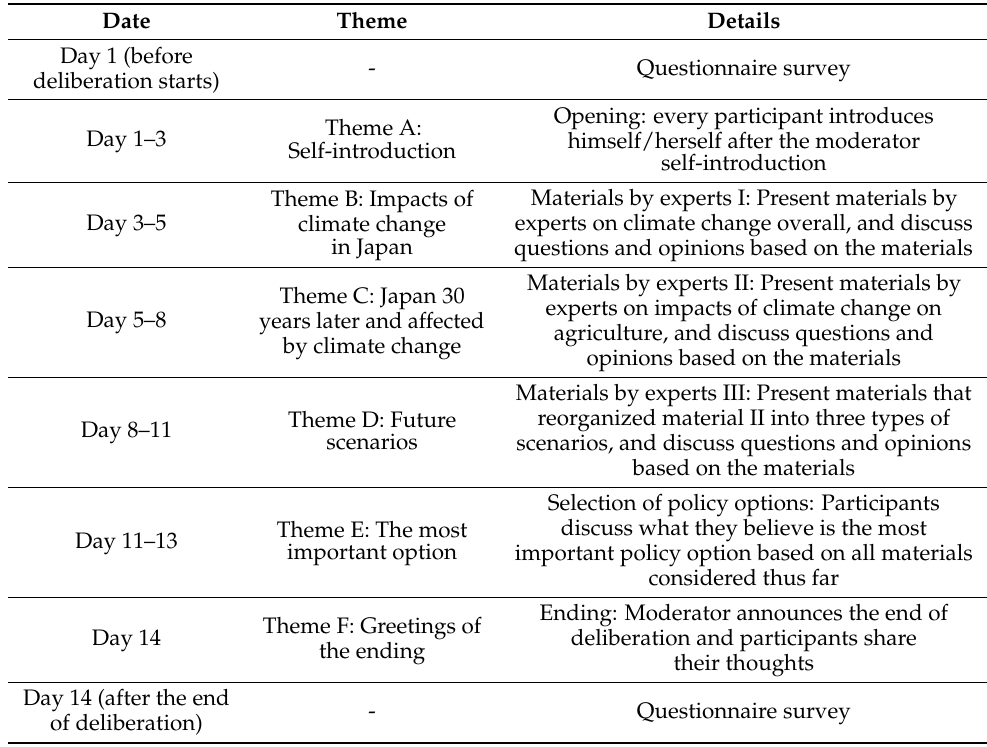
Table 3. Online deliberation